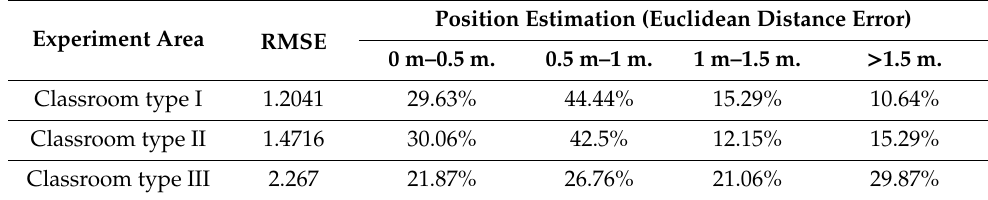
Table 3. Summary result for positioning estimation.